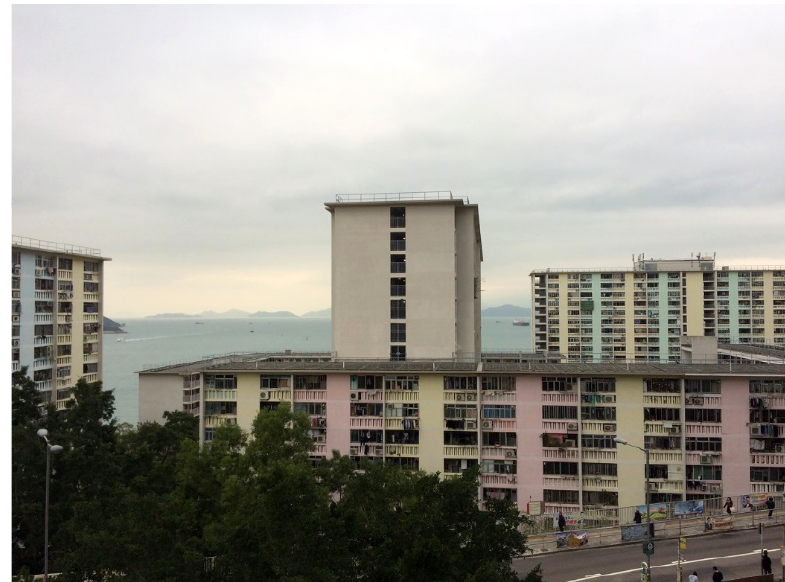
Figure 9. Hong Kong Housing Authority, by chief architect Donald Liao and others, Wah Fu development, Hong